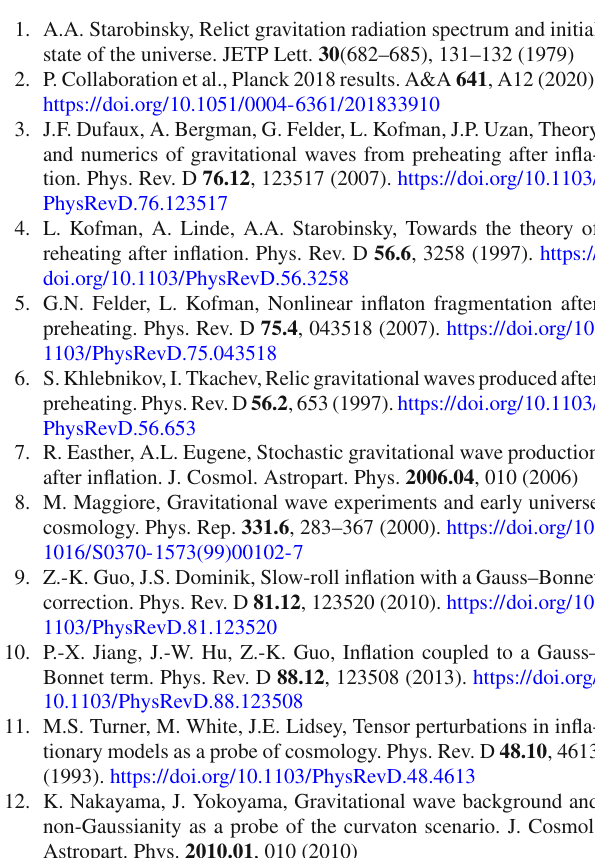
Fig. 4 The variation of the density spectra of GWs as a function of n s . For different values of gravity wave energy density Ω g w, 0 h 2 , we choose 3 . 36 × 10 − 7 ≤ Ω g w, 0 h 2 ≤ 1 . 85 × 10 − 6 . The black line corresponds to Ω g w, 0 h 2 = 1 . 85 × 10 − 6 , red line corresponds to